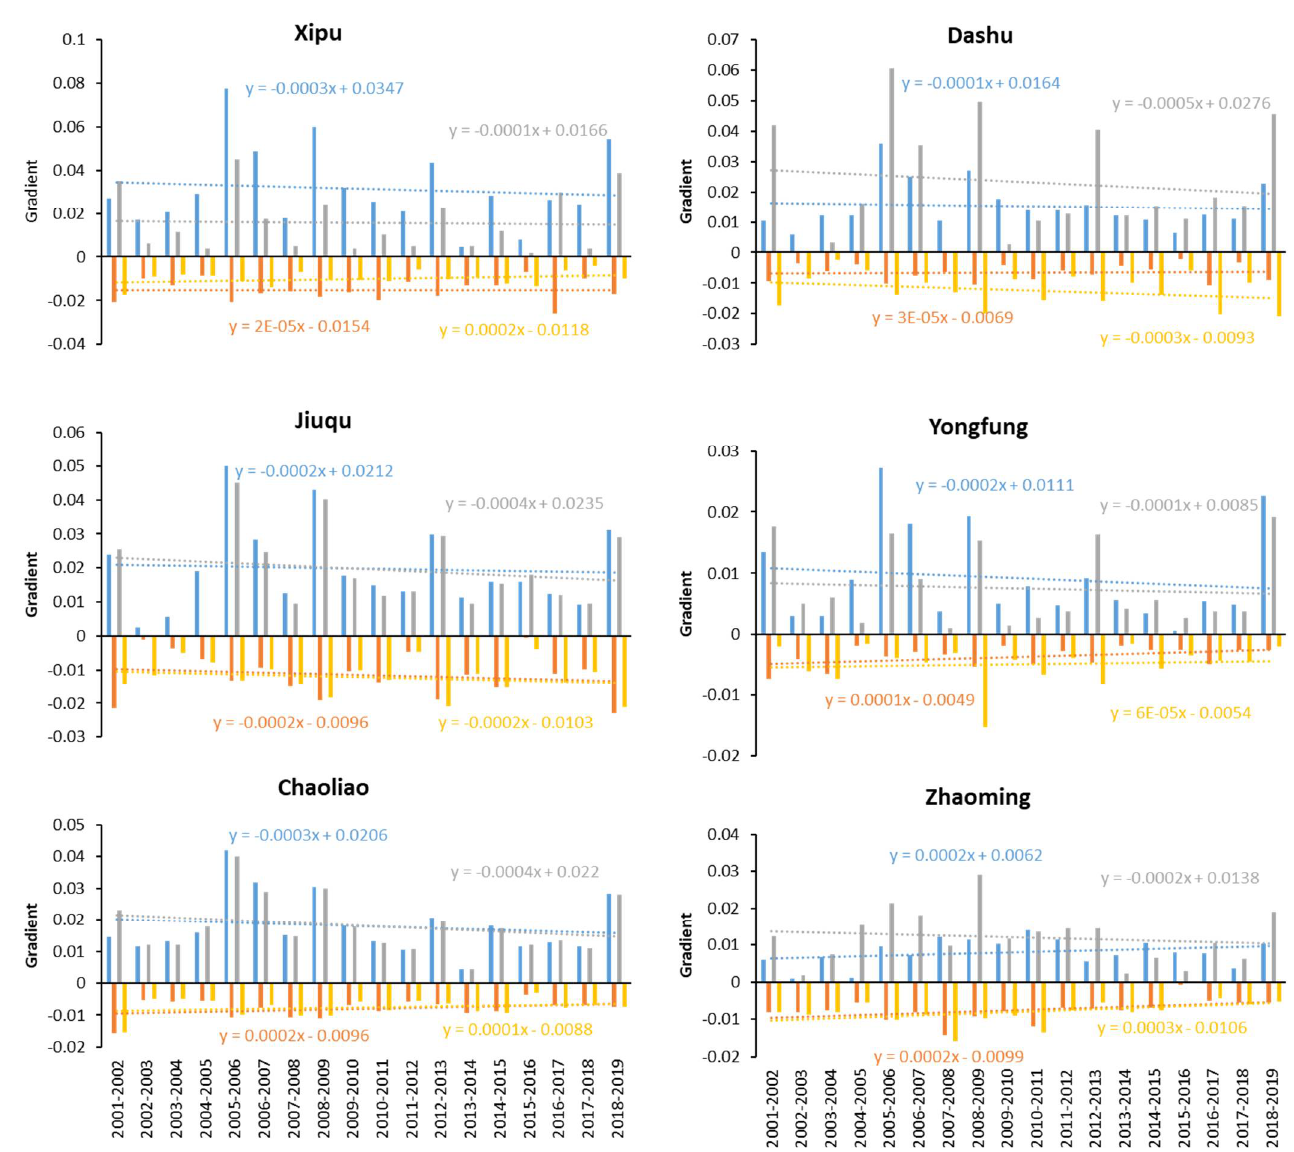
Figure 5. The slope analysis of rising limb (recharge) and recession limb (discharge) of groundwater level hydrograph of each observation well located inside study area for the 2001–2019 period. The blue and grey color ascending bars with the same linear trend line colors represent recharge status in aquifer-1 and aquifer-2, respectively, while orange and gold color descending bars with the lines of the same color represents discharge status in aquifer-1 and aquifer-2, respectively. Meinong, Jiyang and Jiyang Gongzhou stations showed the same kind of patterns in aquifer-1. In Qishan, Zhongzhou, Tuku and Ligang stations indicating some kind of balance between recharge and discharge rate. Xipu, Dashu and Jiuqu sites indicating different patterns of recharge and discharge rate in both aquifers. At Yongfung and Chaoliao sites, the recharge and discharge rates are de-creasing in both aquifers.